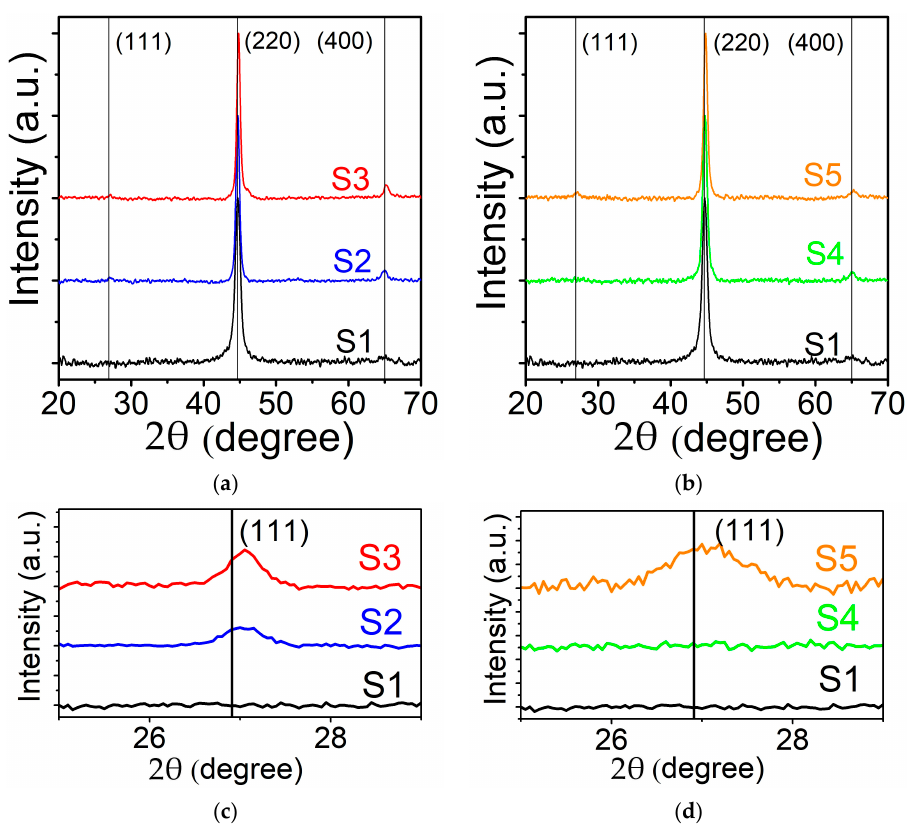
Figure 2. GIXRD patterns for Co 2 FeGe films: ( a ) deposited at T S = RT (S1), T S = 573 K (S2), T S = 773 K (S3); ( b ) deposited at RT and annealed for 1 h at T a = 573 K (S4), T a = 773 K (S5). Close-ups for (111) reflection area for films: ( c ) deposited at different T S ; ( d ) for films deposited at RT and annealed at different T a for 1 h.